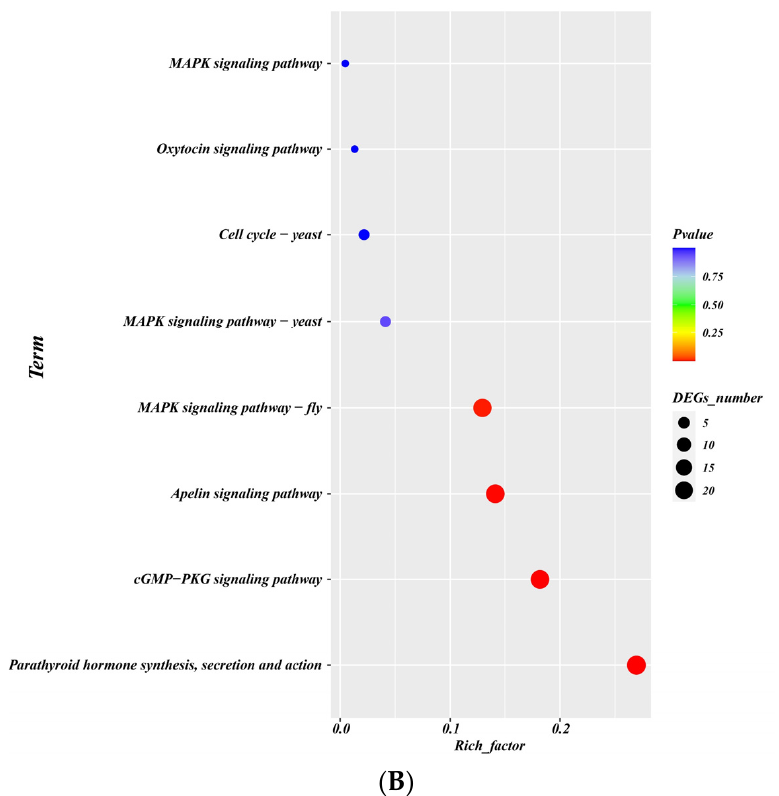
Figure 6. GO and KEGG pathway analysis of 70 MADS genes. ( A ) GO ontology of 70 MADS genes. The vertical axis represents different go terms, and the horizontal axis represents the number of genes enriched. MF: molecular function; CC: cellar component; BP: biological process. ( B ) KEGG pathway of 70 MADS genes.